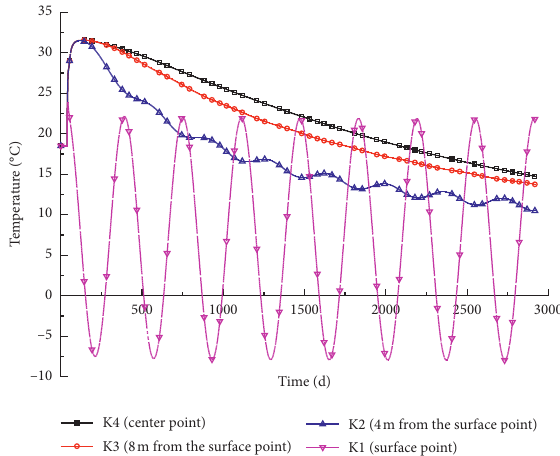
Figure 10: The temperature duration curves at different positions of dam height of